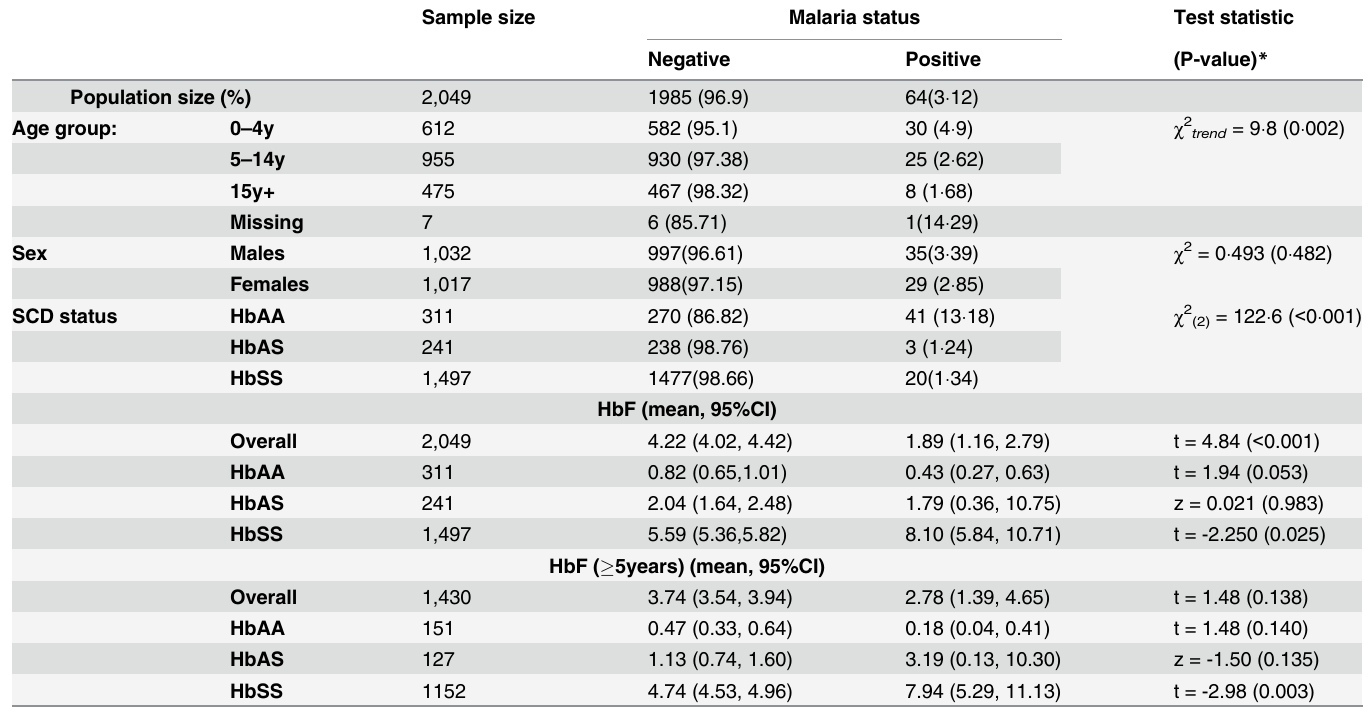
Table 1. Characteristics of the study participants at baseline